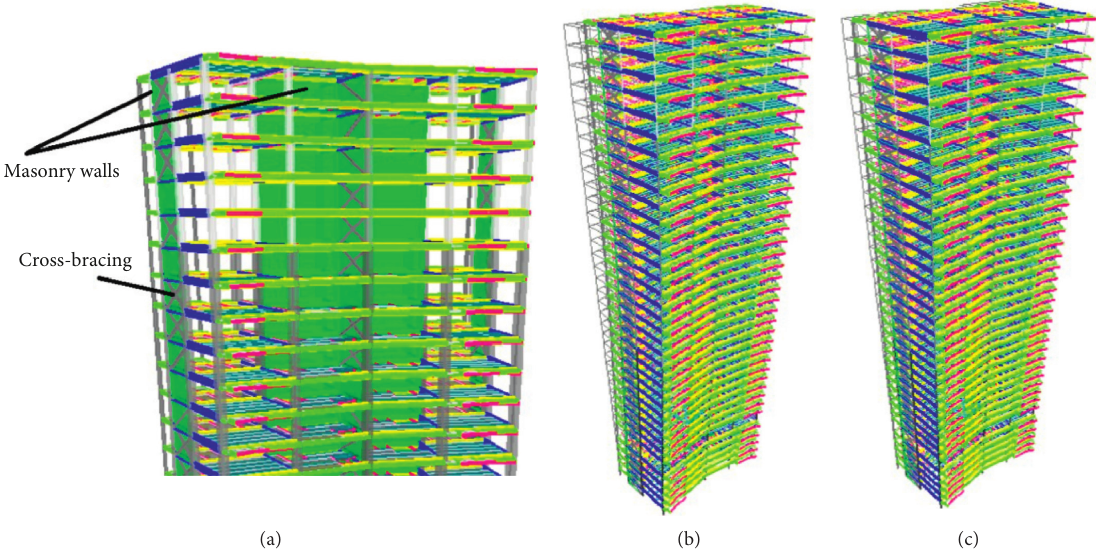
� 3.65s. (c) T � 3.44s. xz ,1 yz ,1